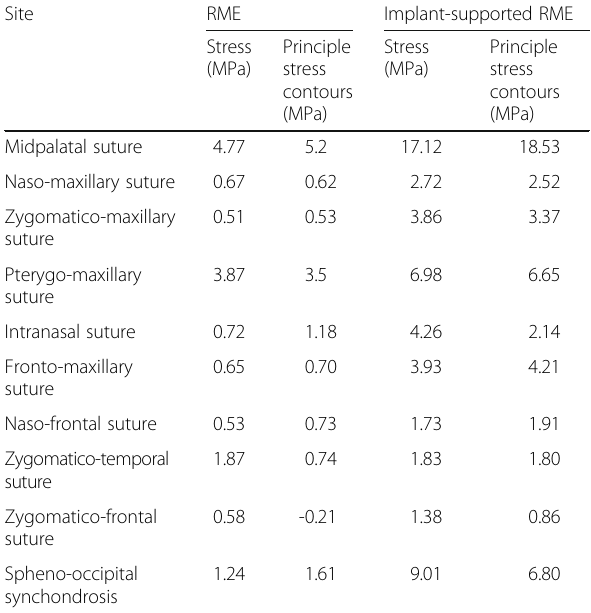
Table 2 Comparison of stresses between RME and I-RME Site RME Implant-supported RME